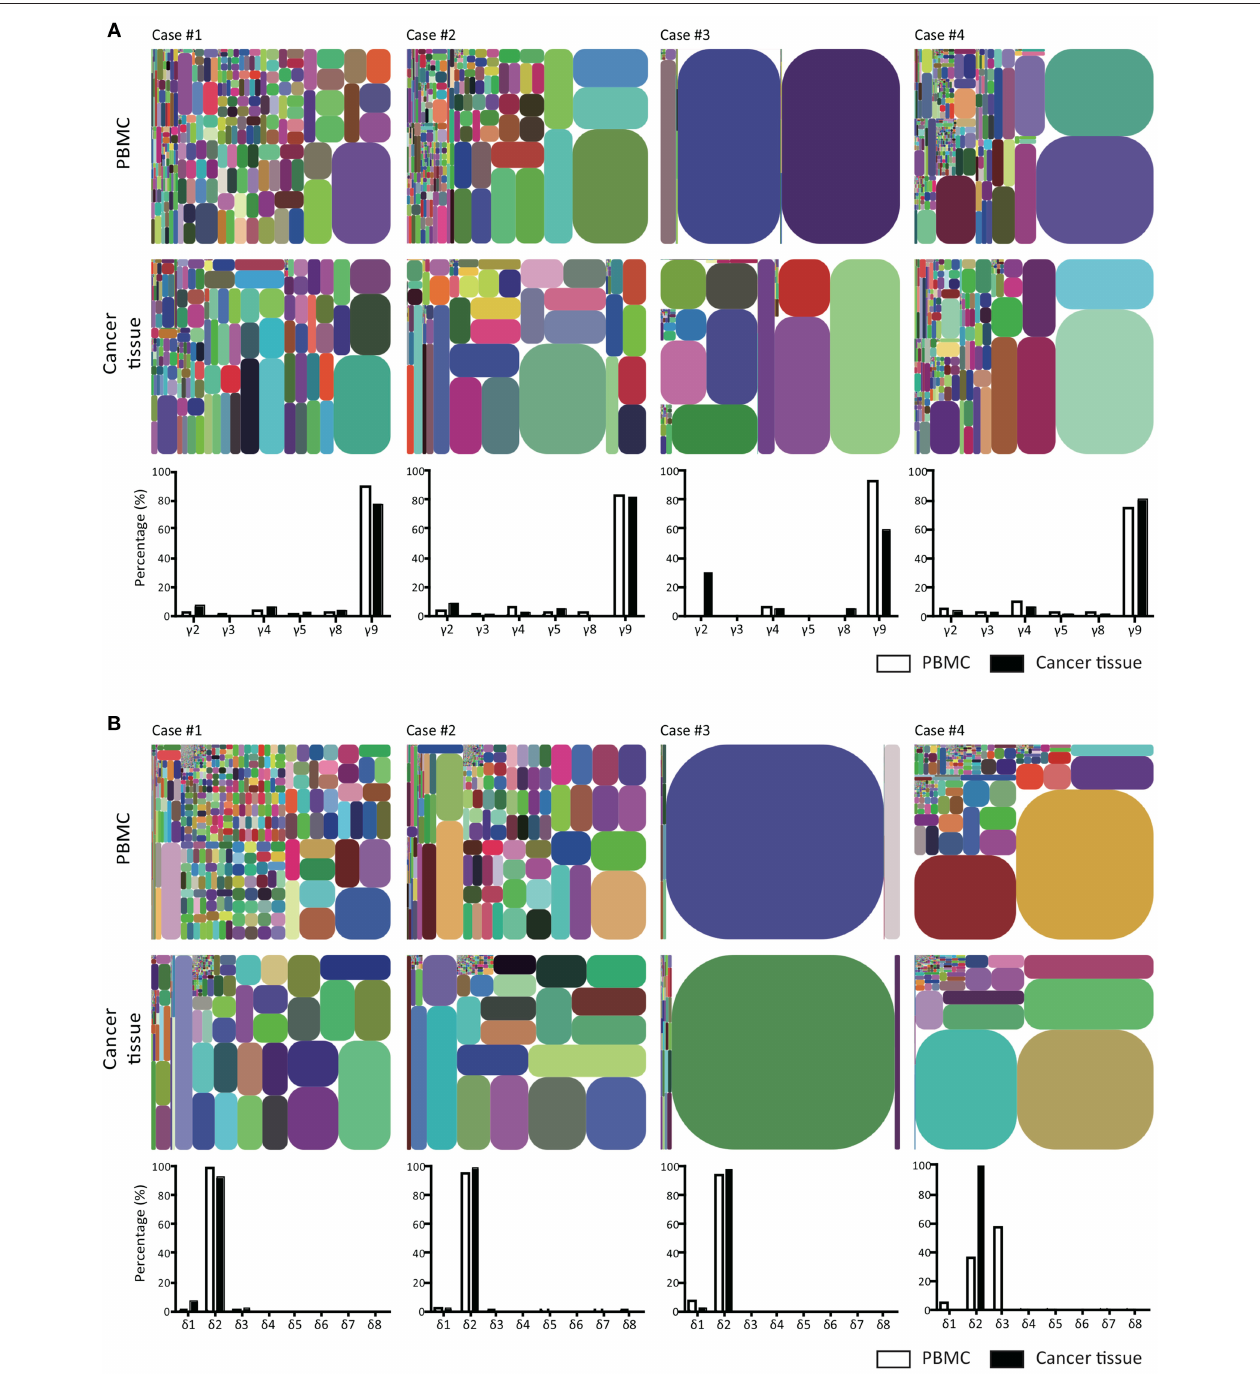
FIGURE 3 | T cell receptor γ and δ chain CDR3 tree map plots for blood and GBM tumor tissue γδ T cells and the relative proportions of individual TCR TCR V γ or V δ gene segments. (A) for TCR γ (B) for TCR δ . CDR3 tree-map plots illustrate the unique TCR γ or TCR δ CDR3 nucleotide sequences obtained from given samples of four GBM patients. Each rectangle in a given tree-map represents a unique CDR3 sequence, and the size of each rectangle indicates the relative frequency of an individual sequence. The colors for the individual CDR3 sequences in each tree-map plot were chosen randomly. Bottom graphs in (A,B) show the percentages of use of each TCR V γ (A) or V δ (B) domain in PBMCs (white) or cancer tissues (black) from each patient.